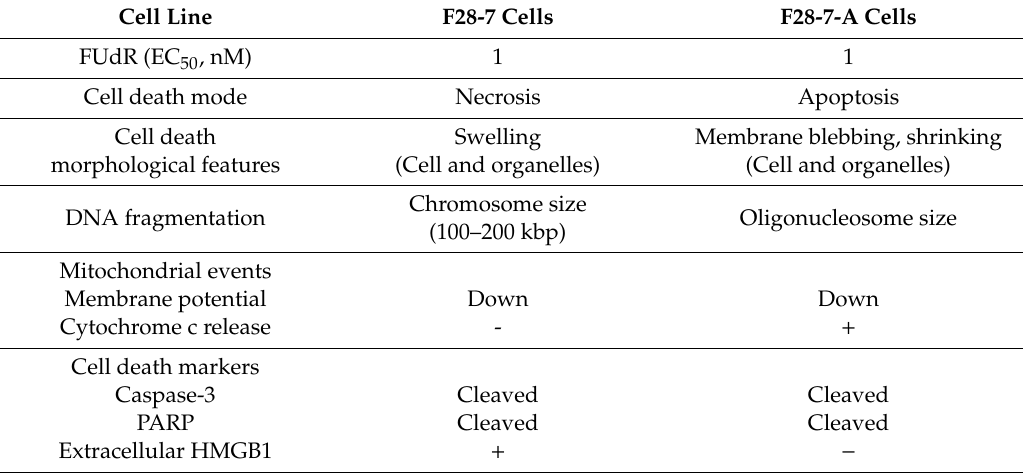
Table 1. The biological and morphological features of FUdR-induced cell